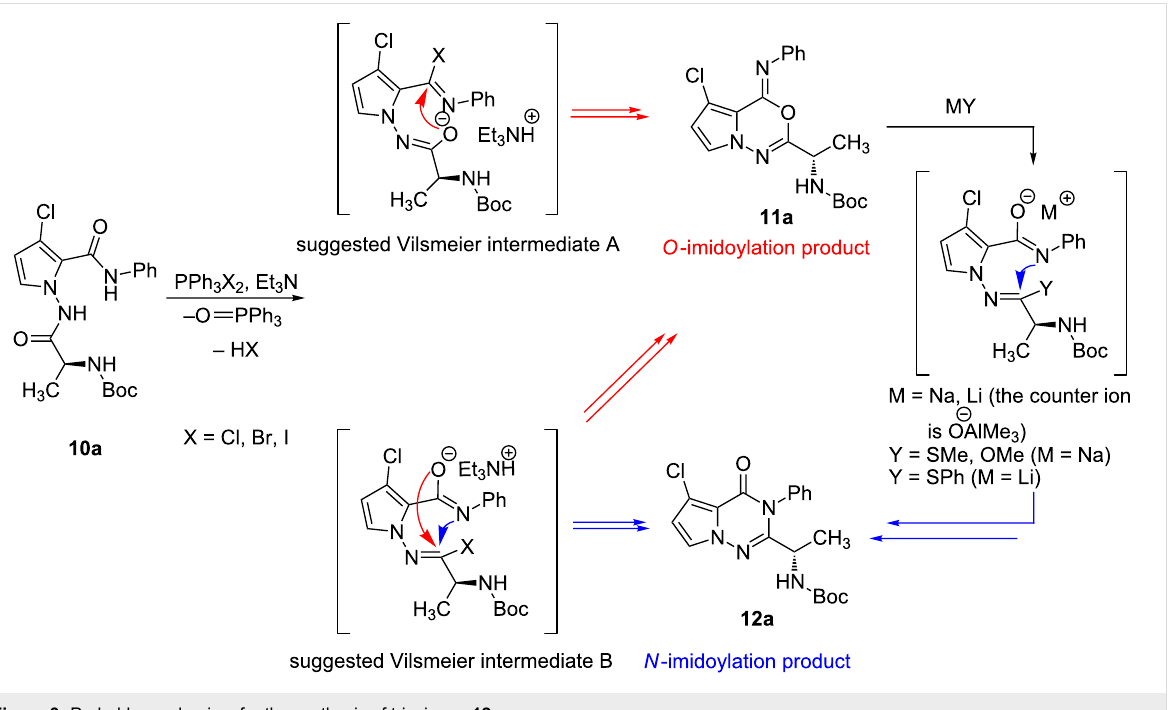
Figure 3: Probable mechanism for the synthesis of triazinone 12a